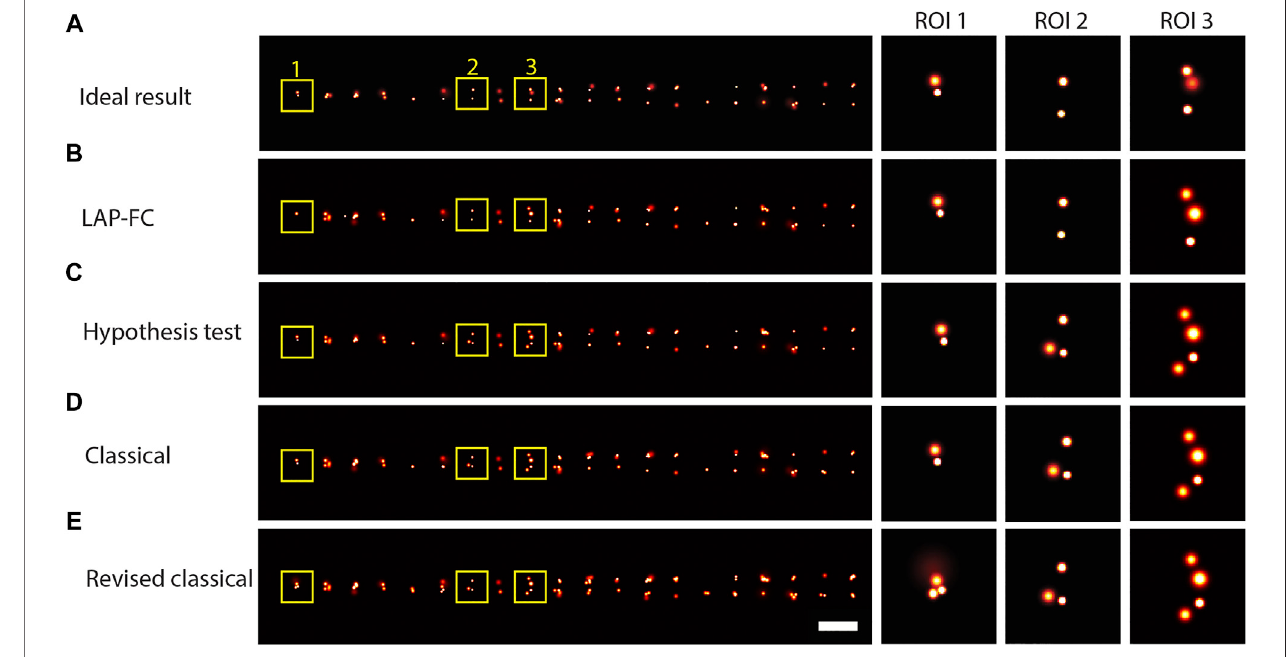
Frontiers in Bioinformatics |